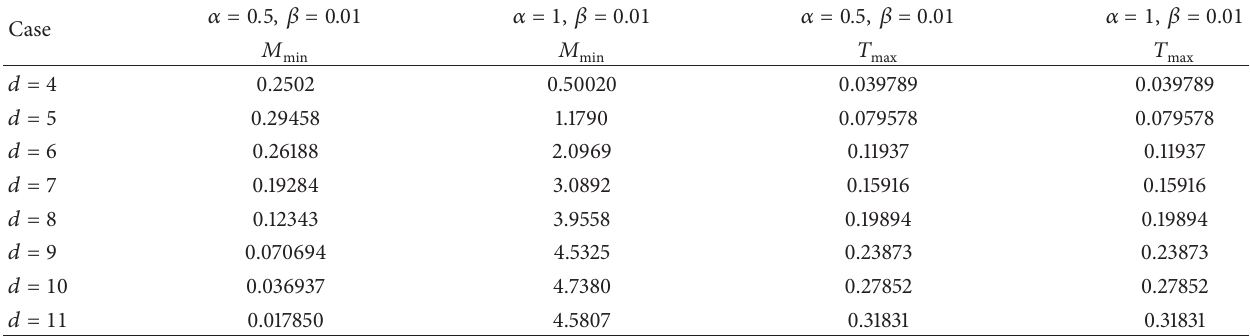
Table 2: GUP ∗∗ -corrected maximum temperature and minimum mass of black hole for different values of parameters 𝛼 and 𝛽 in scenarios with large extra dimensions. Mass is in unit of the Planck mass and temperature is in unit of the Planck energy (supposing 𝑀 𝑝 = 1 ). 𝛼 = 0.5, 𝛽 = 0.01 𝛼 = 1, 𝛽 = 0.01 𝛼 = 0.5, 𝛽 = Case